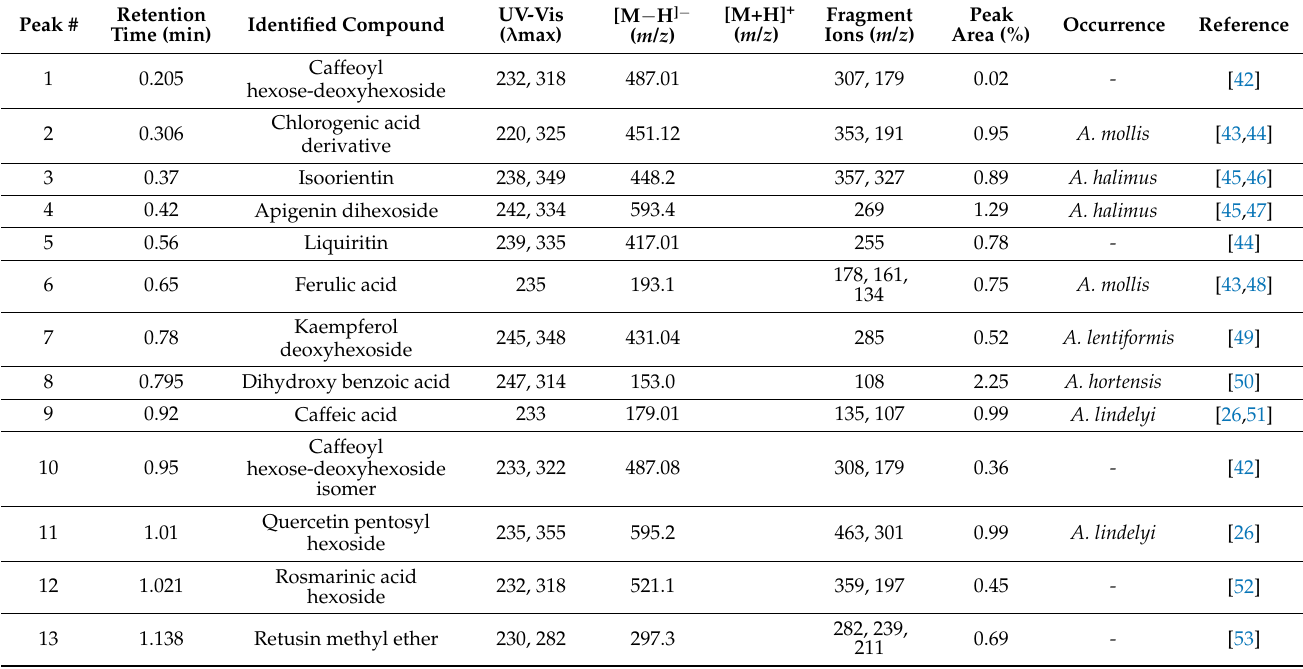
Table 2. Peak assignment using UPLC-PDA-ESI-MS/MS of the active metabolites detected in A. dimorphostegia L.